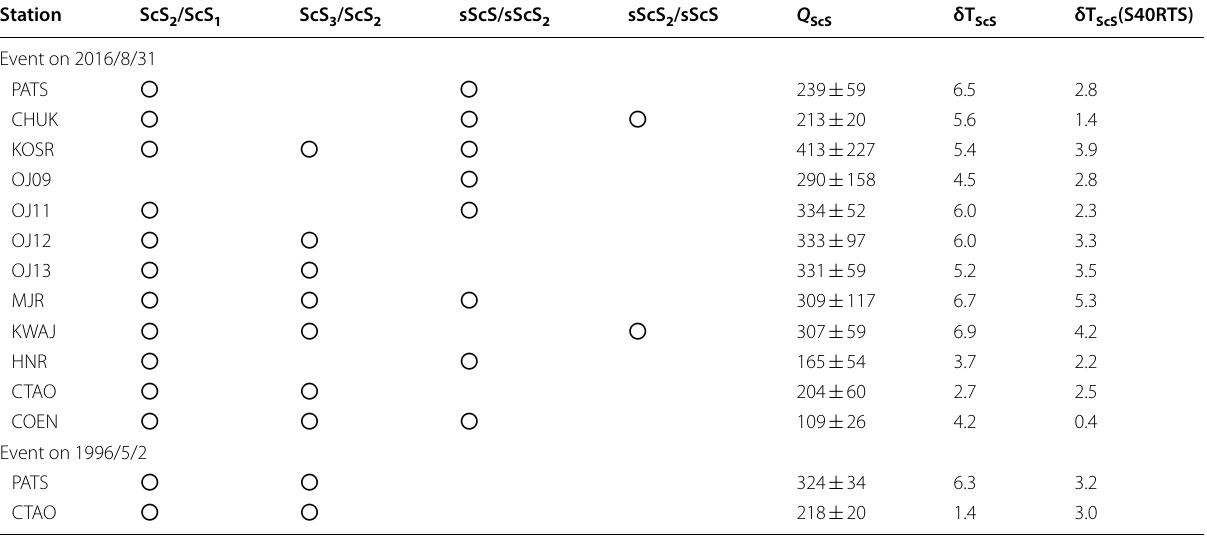
Table 1 Q , standard errors, travel time residuals, and theoretical travel time residuals calculated from S40RTS (Ritsema ScS et al. 2010), and pairs of multiple ScS used in the present study